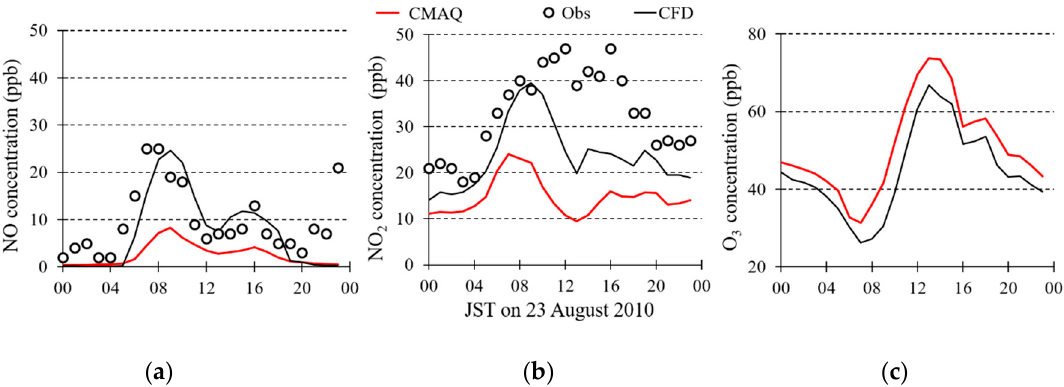
Figure 6. Diurnal variations in CMAQ-simulated, observed, and CFD-simulated ( a ) NO; ( b ) NO 2 ; ( c ) O 3 concentrations at the Umeda-Shinmichi station for monitoring roadside air pollution on 23 August 2010.